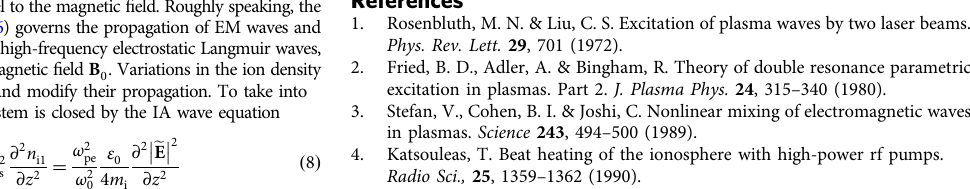
Figure 3 were obtained using the ‘ heatererp ’ software written by A. Senior with contributions by M. T. Rietveld, freely available at https://gitlab.com/andrewsenior/